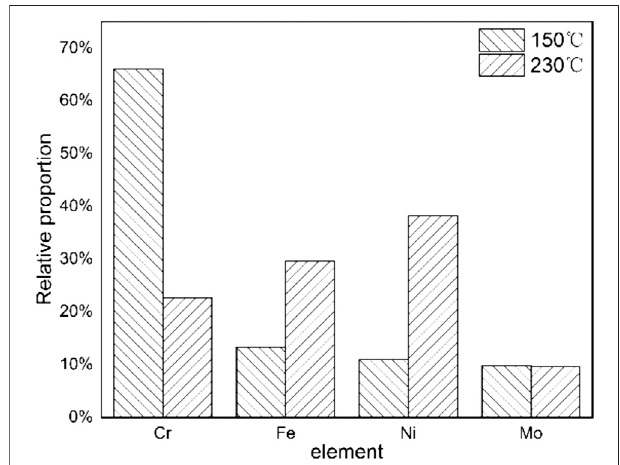
FIGURE 7 | The comparison of relative proportions of the elements in passive fi lm of Alloy 825 under two